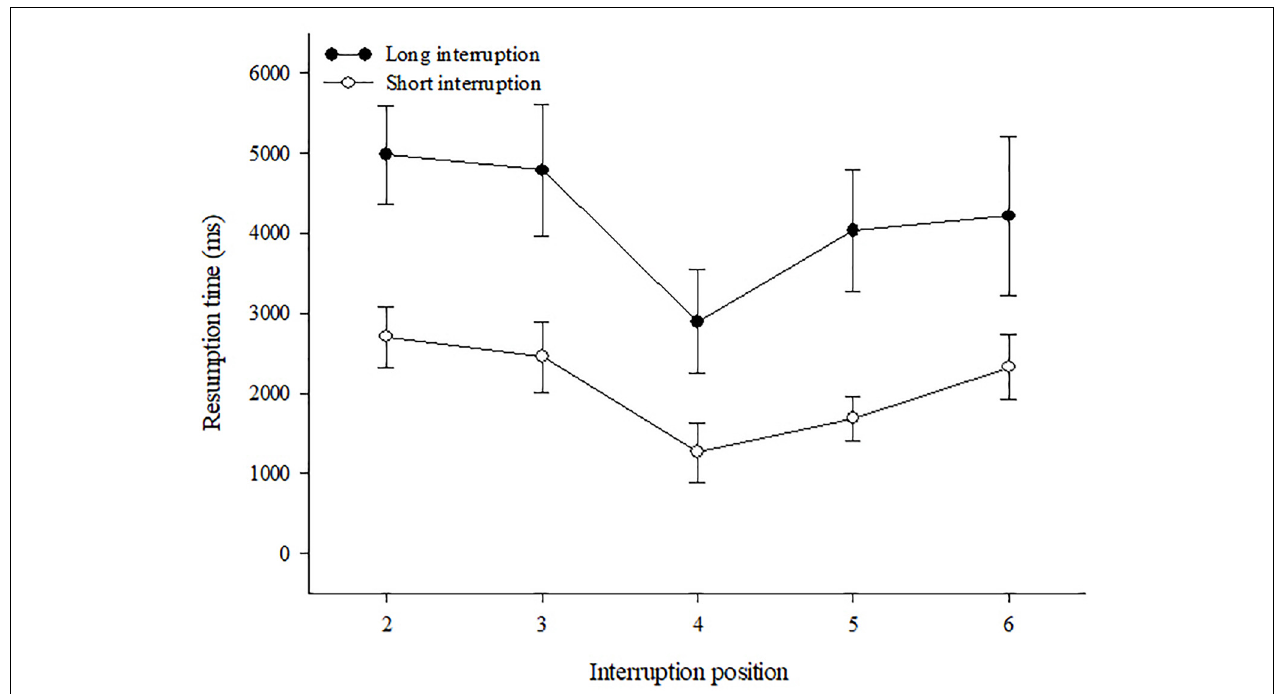
FIGURE 4 | Resumption times and standard errors for short and long interruption length at different interruption positions.